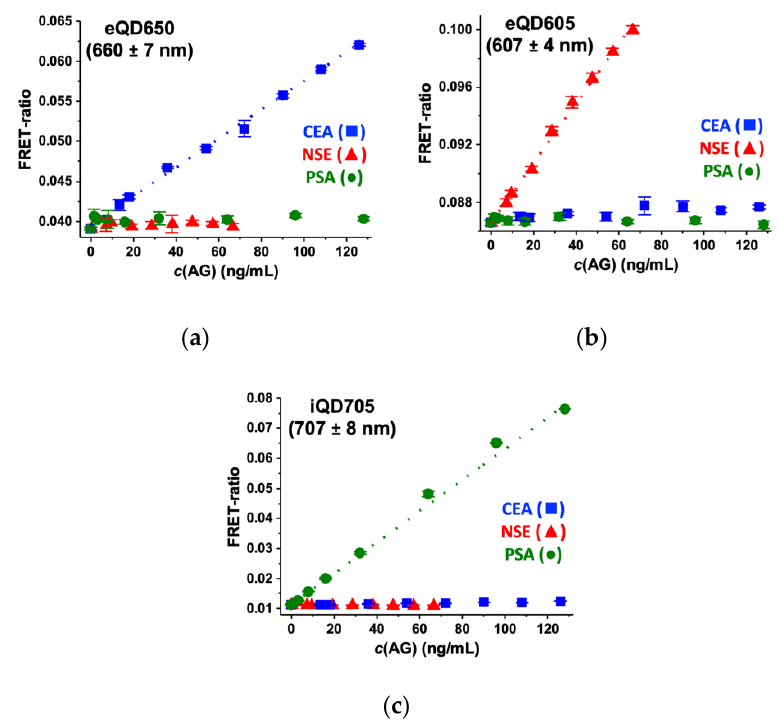
Figure 6. FRET immunoassay calibration curves of CEA, nsE, and PSA (all AB FRET pairs were present in all samples) to determine the optical crosstalk in: ( a ) the eQD650 detection channel for CEA; ( b ) the eQD605 detection channel for nsE; and ( c ) the iQD705 detection channel for PSA. Dotted lines show the linear fits of the AG-specific calibration curves that were used for the determination of